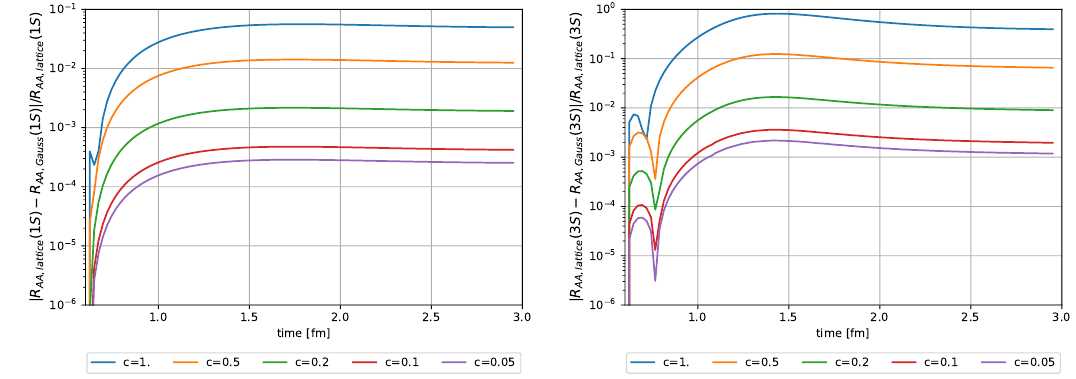
Figure 1 . Relative difference in R AA , computed as in [32, 33], when using a Gaussian regulated delta function and a finite lattice regulated delta function defined according to